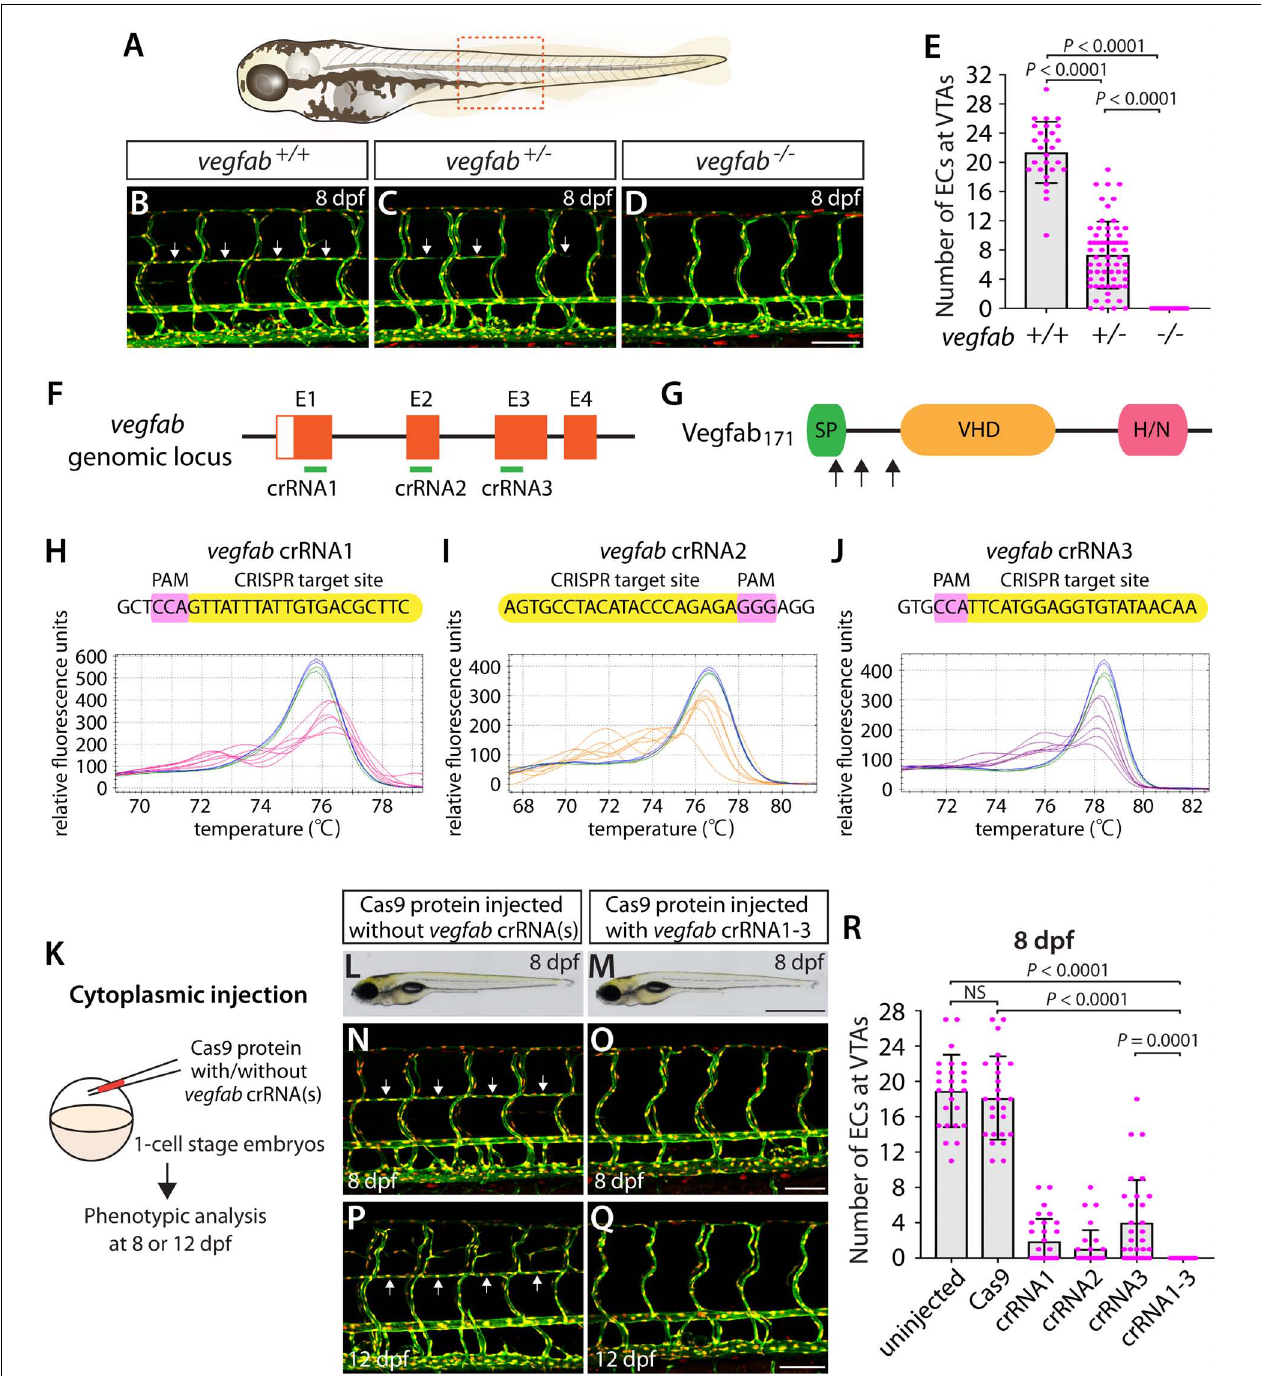
FIGURE 4 | Larvae injected with three unique vegfab dgRNPs phenocopied the complete loss of VTAs observed in vegfab − / − fish. (A) Schematic representation of the lateral view of an 8 dpf zebrafish larva. The boxed area indicates the approximate trunk region where all VTA quantifications were performed. (B–D) Lateral trunk views of 8 dpf vegfab + / + , vegfab + / − , and vegfab − / − larvae carrying Tg(kdrl:EGFP) and Tg(kdrl:NLS-mCherry) transgenes. While vegfab + / + larvae formed the VTAs, which extended bilaterally along the ventrolateral sides of the spinal cord ( B, arrows), vegfab − / − larvae formed no VTAs (D) . Most vegfab + / − larvae exhibited partially forming VTAs at this stage ( C, arrows). (E) Quantification of endothelial cells (ECs) at the VTAs within a 5 somite region per animal at 8 dpf ( n = 27 for vegfab + / + , n = 64 for vegfab + / − , and n = 35 for vegfab − / − fish). (F) Three synthetic crRNAs were designed to target sequences within exon 1 (E1), E2, and E3 on the vegfab genomic locus. (G) Predicted domain structure of zebrafish Vegfab 171 isoform. Vegfab 171 consists of a signal peptide (SP), a VEGF homology domain (VHD), and a heparin and neuropilin1 binding domain (H/N). Arrows indicate the approximate positions of the protein sequences corresponding to the target sequences of the